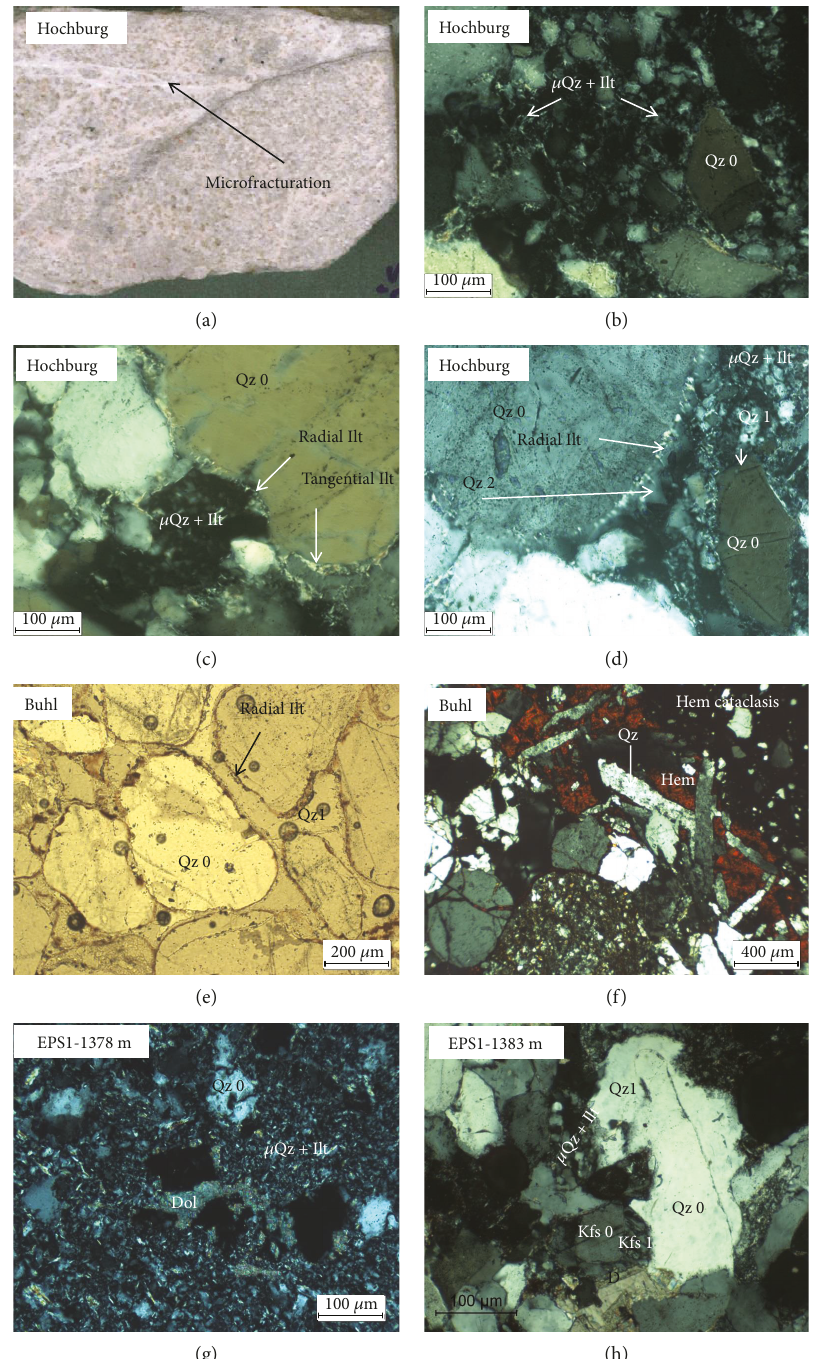
Figure 8: Fractures and matrix along fractures in sandstones. (a, b, c, d) Example from Hochburg: (a) Whitish and microfracture cutting across sandstone; (b) microscopic image of whitish microfractures that provide evidence of cohesive microcataclasite cemented by microquartz ( μ Qz) and illite (Ilt) (polarized light); (c) detail of the matrix along the whitish microfracture, showing microquartz and illite ( μ Qz +Ilt) and cements of radial illite and tangential illite (polarized light); (d) another detail of the matrix showing quartz overgrowth, cement of microquartz and illite, and growth of radial illite on detrital quartz cemented by diagenetic quartz (Qz1) (polarized light); (e, f) example from Buhl: (e) matrix of fractured sandstone showing massive quartz cementation (Qza) of detrital quartz surrounded by radial illite (natural light); (f) cohesive microcataclasite cemented by quartz and hematite (Hem), then crosscut by a vein of quartz and hematite (polarized light); (g, h) Examples from EPS1 well: (g) fracture at 1378m showing cohesive cataclasite cemented by microquartz and illite, then crosscut by dolomite fi lling (polarized light); (h) sandstone matrix at 1383m showing late dolomite cementing all the earlier authigenic minerals (polarized